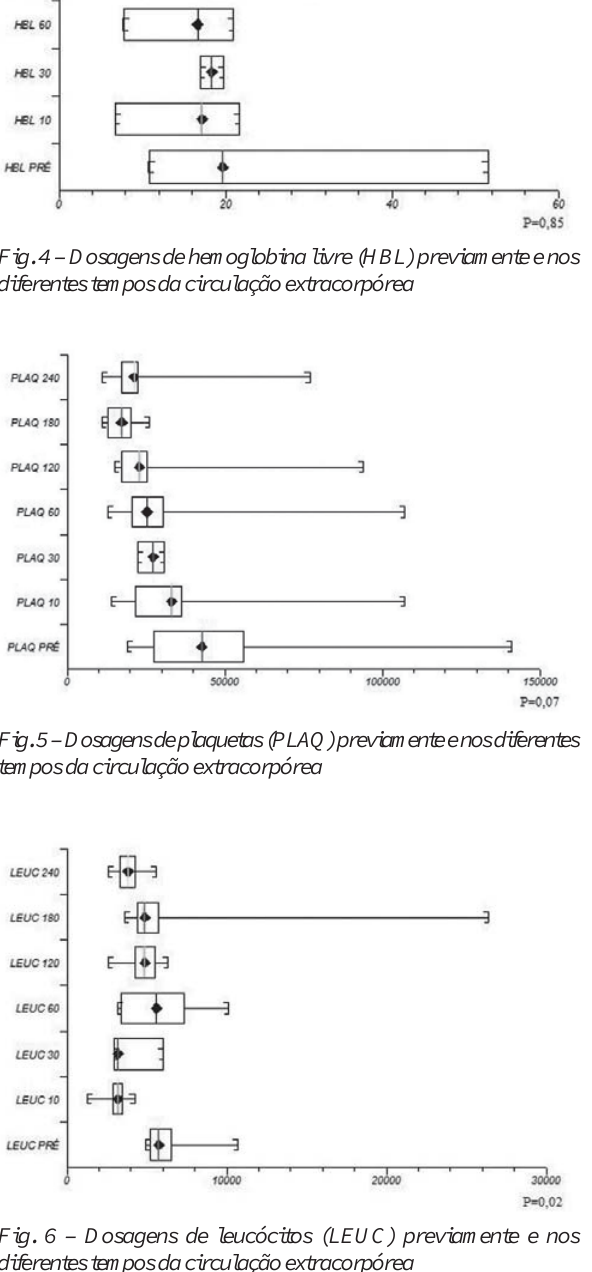
A troca de calor foi efetiva, observando-se que a temperatura mediana previamente à CEC foi de 37,6ºC e durante a CEC apresentou variação significativa (p=0,01),